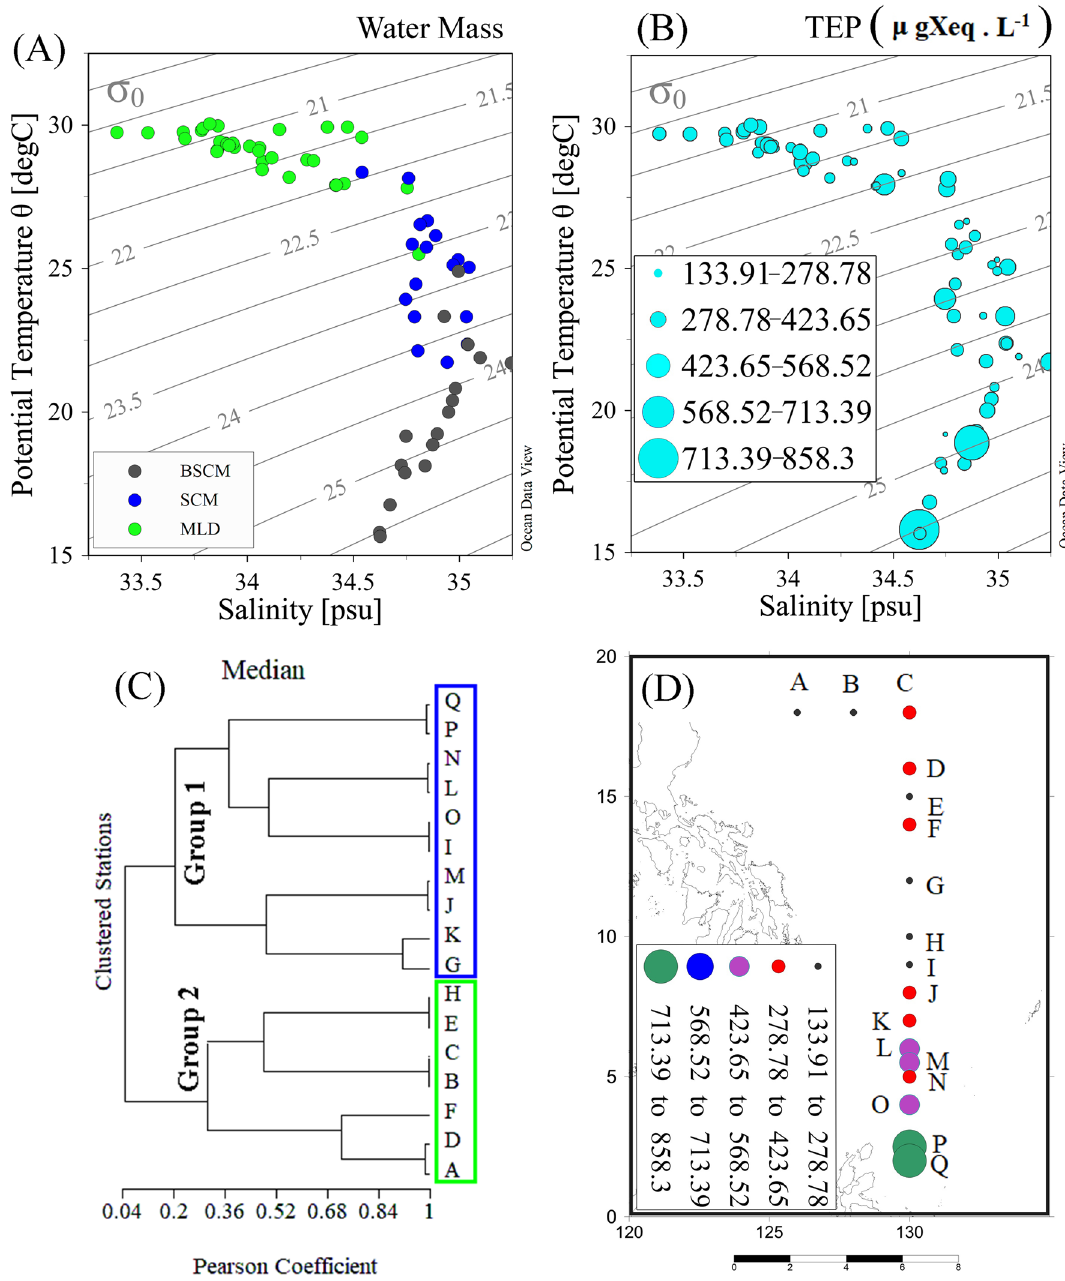
Figure 2. TS diagraph of samples with water density gradients ( A ) compared to TEP concentrations along those water masses ( B ). Cluster analysis of all stations considering nutrients as variables ( C ) and average TEP concentrations ( D ) at the